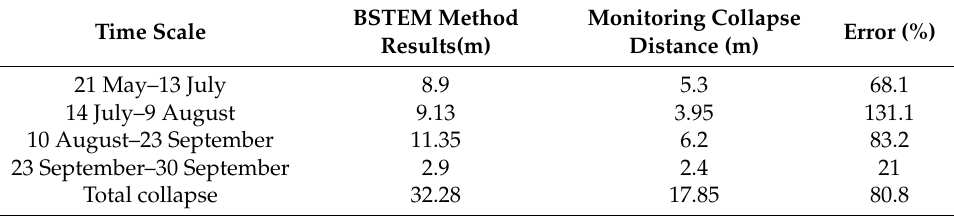
Table 14. BSTEM results, field measurements and errors for surveying Section 4.